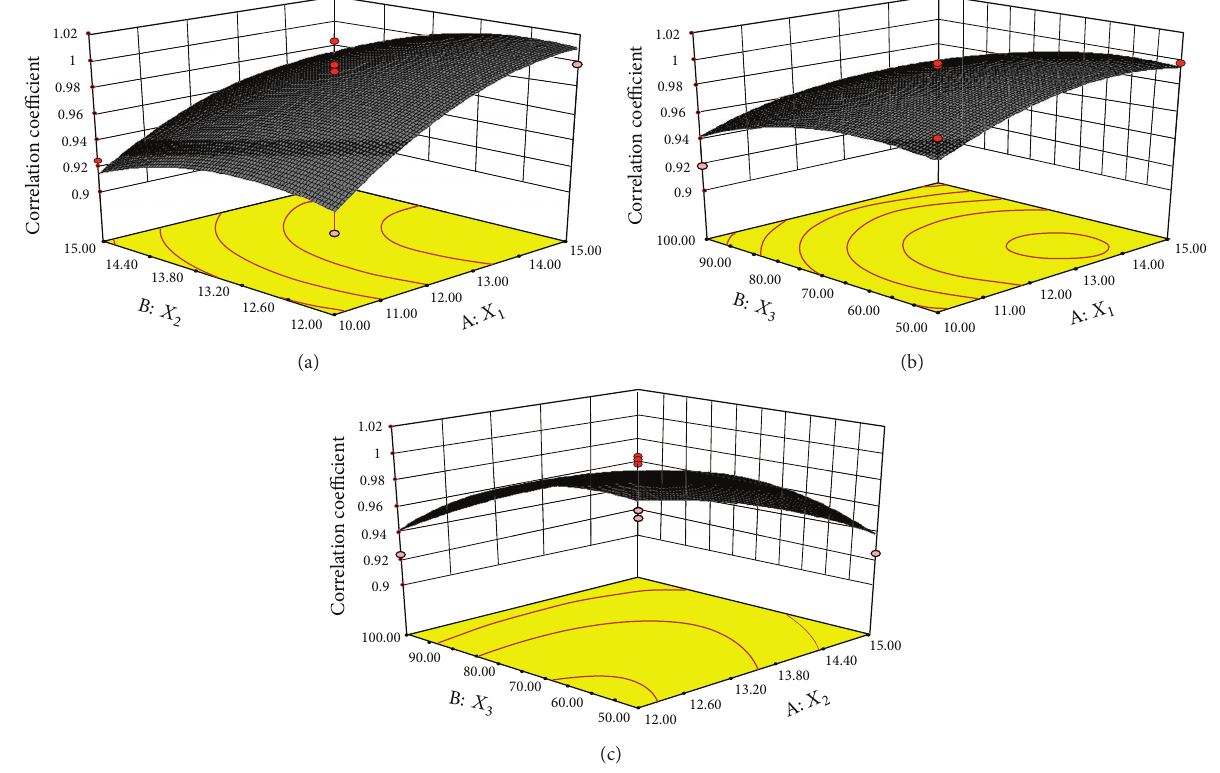
Figure 4: 3D-response surface plots for correlation coefficient as functions of two factors.